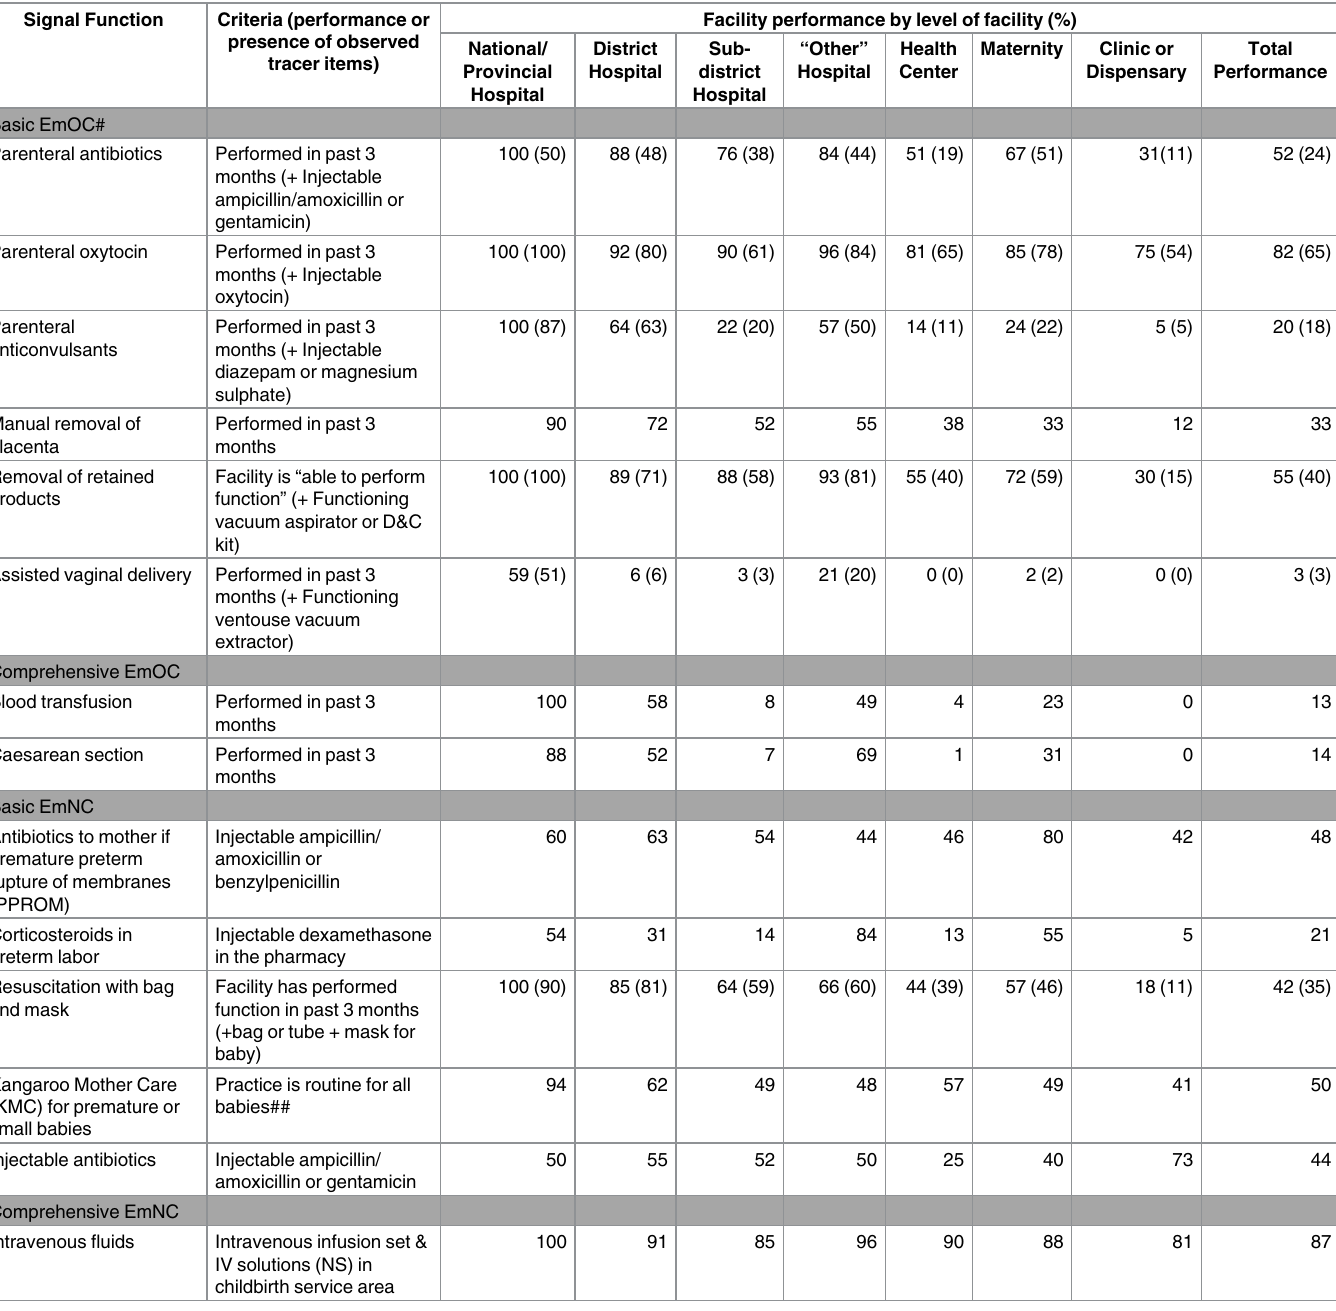
Table 3. Emergencychildbirth care capability by facility